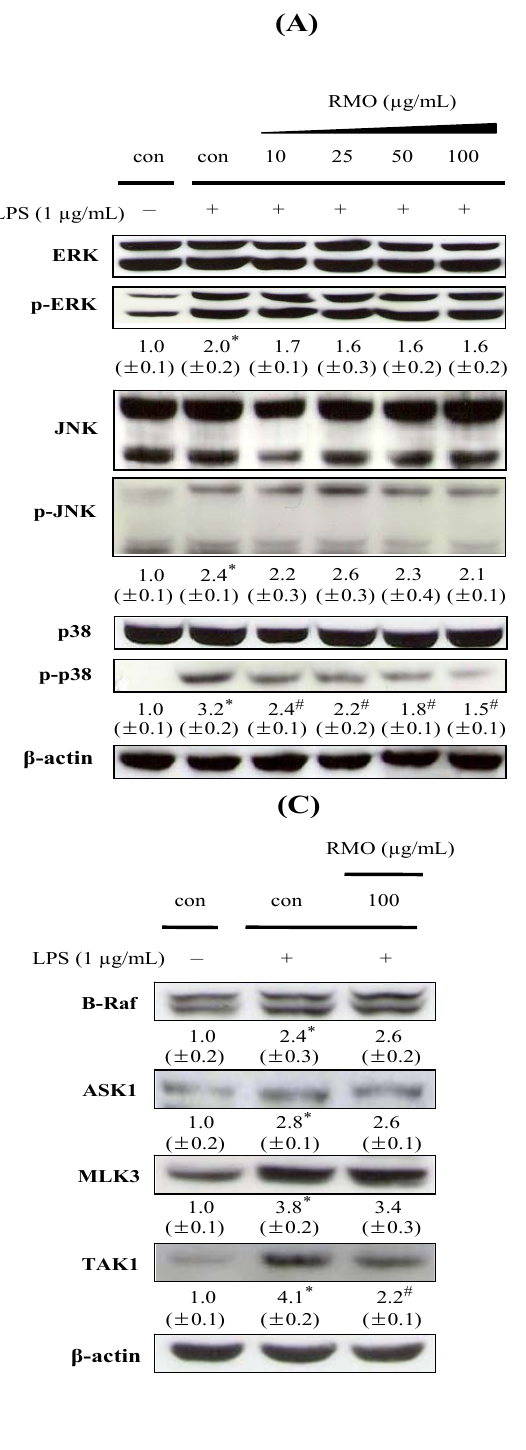
Figure 5. Effects of RMO on MAPK, MAPKK and MAPKKK phosphorylation in LPS-induced RAW 264.7 cells. Cells were treated with RMO for 1 h and stimulated with LPS ( A ) for 1 h, ( B ) 30 min, and ( C ) 15 min. Cell lysates were then subjected to Western blot analysis for the indicated proteins. The results are expressed as the means ± S.D. for three separate experiments, each with three